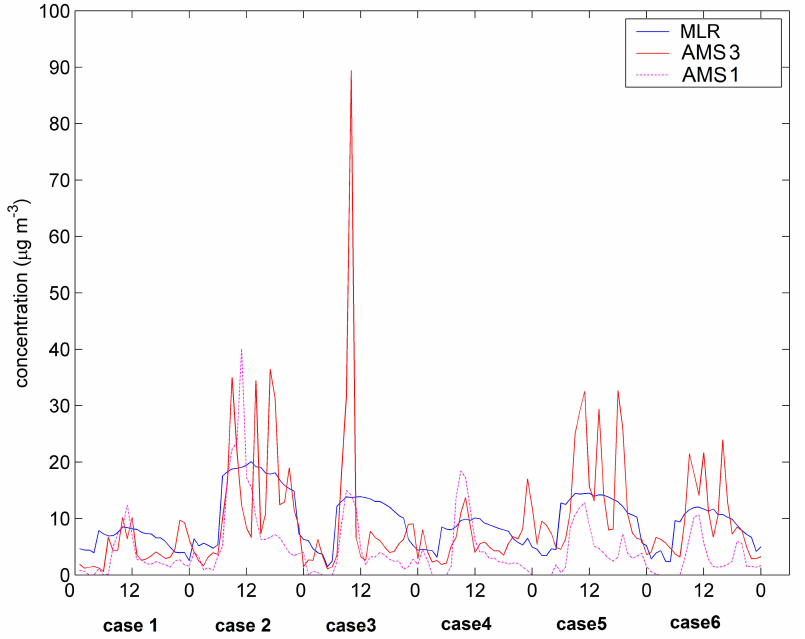
Figure 6. Hourly multiple linear regression (MLR)-model-simulated and measured SO 2 concentra- tions for selected sea breeze cases in April 2007–2009 at the AMS 3 Split-1 station in comparison with the measurements at the AMS 1 Kaštel-Su´curac